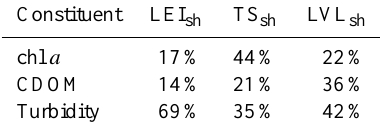
Table 3. Contributions to light attenuation from three constituents. The effect of water depth is removed from these calculations. Constituent LEI sh TS sh LVL sh